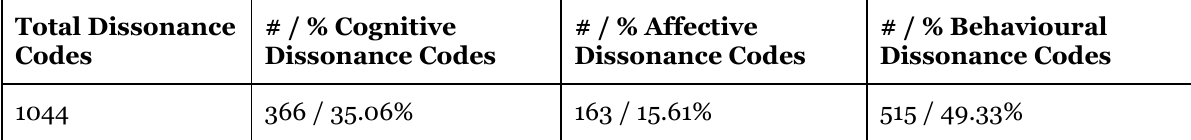
Dissonance Codes